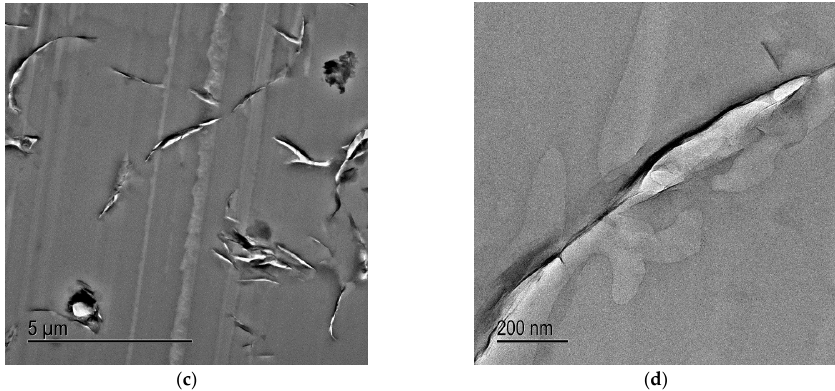
Figure 13. TEM micrographs of sub critical point of the crack initiation site of D-clay ( a , b ) and V-clay ( c , d ) epoxy composites.